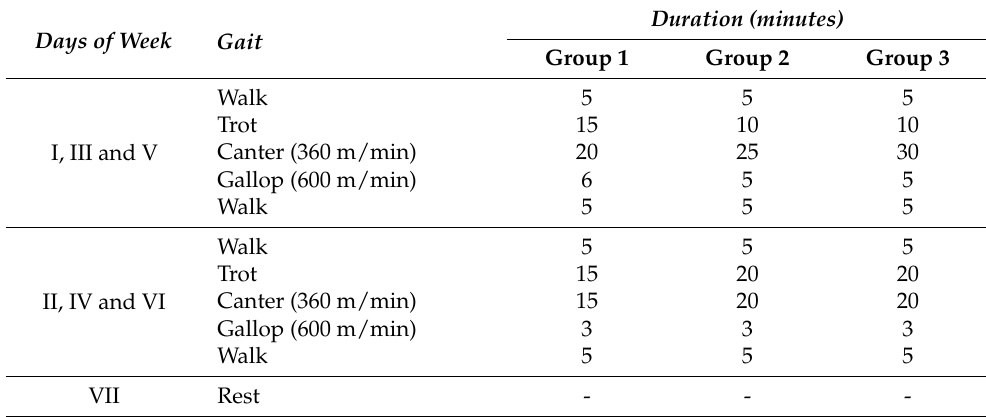
Table 1. Schedules of training program performed by horses belonging to Group 1 (1200 m/race; n =